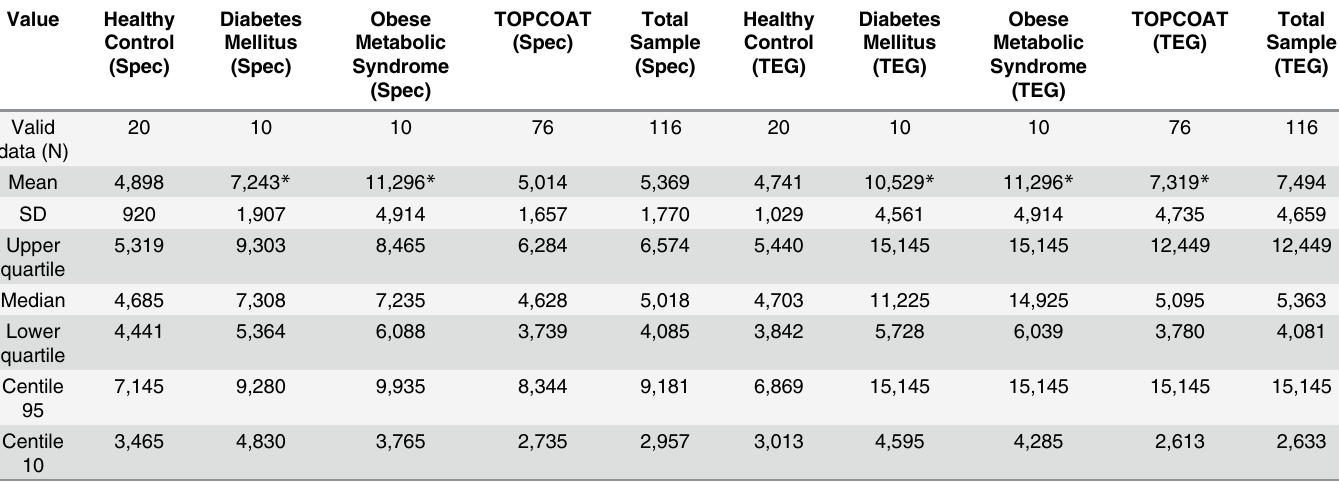
* p < 0.05 from one-way ANOVA with Dunnett ’ s comparison with control Abbreviations: Spec-spectrophotometry (turbidimetric method); TEG-Thromboelastography; TOPCOAT-tenecteplase or placebo: cardiopulmonary outcomes at three months; SD-Standard